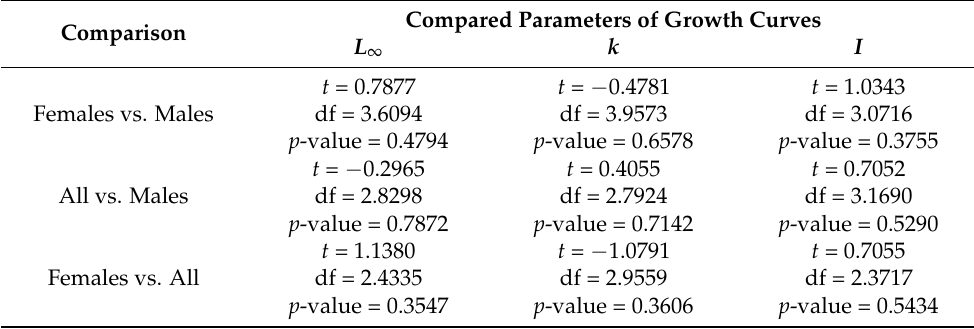
Figure 6. Gompertz best-fitting growth curves of Myctophum punctatum for all individuals and separated by sex. Table 4. t -test results of the growth curves’ coefficients ( L ∞ , K, t 0 or I ) of the age-at-length data be- tween females, males and all individuals.